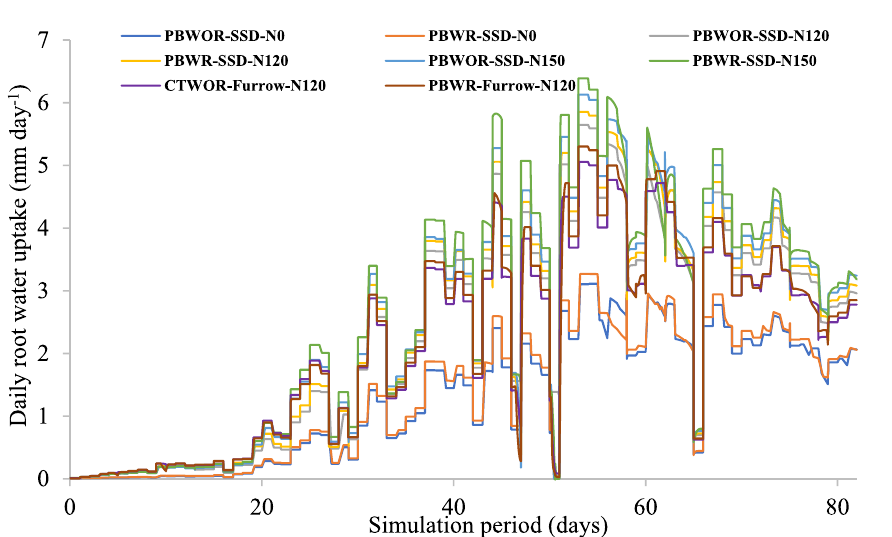
Figure 4. Daily root water uptake (mm day −1 ) pattern during the simulation period in maize under contrasting tillage, residue, N and irrigation treatments. For treatment detail please see Table